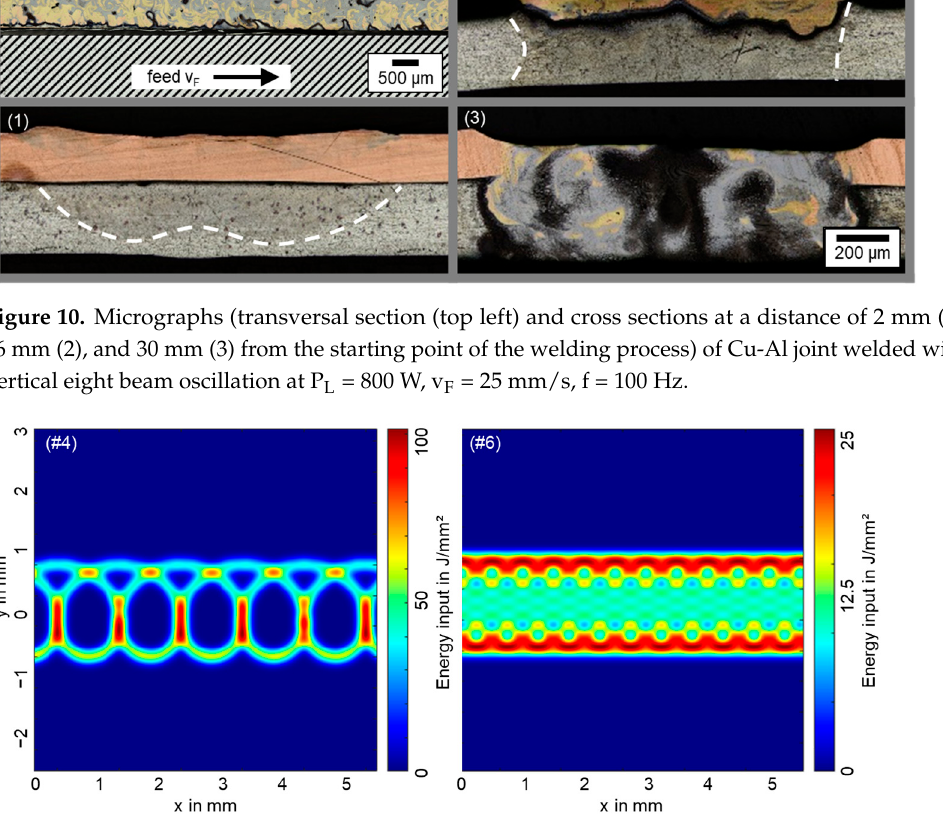
Figure 10. Micrographs (transversal section (top left) and cross sections at a distance of 2 mm (1), 16 mm (2), and 30 mm (3) from the starting point of the welding process) of Cu-Al joint welded with vertical eight beam oscillation at P L = 800 W, v F = 25 mm/s, f = 100 Hz.